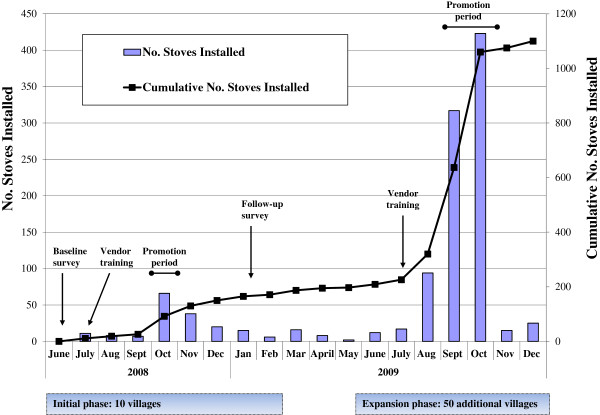
No. of upesi jiko installed in all 60 villages, Nyanza Province, Kenya, July, 2008–December, 2009a.aUpesi jiko are ceramic-lined cookstoves that are produced locally. Sales dates were not available for 9 transactions.